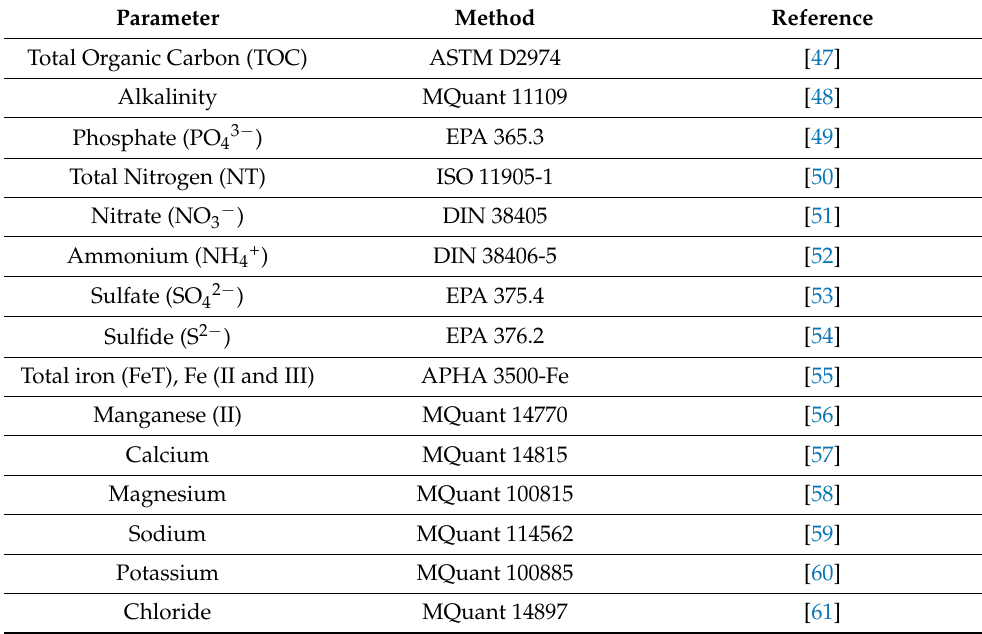
Table 2. Analytical methods for characterization of the combined water